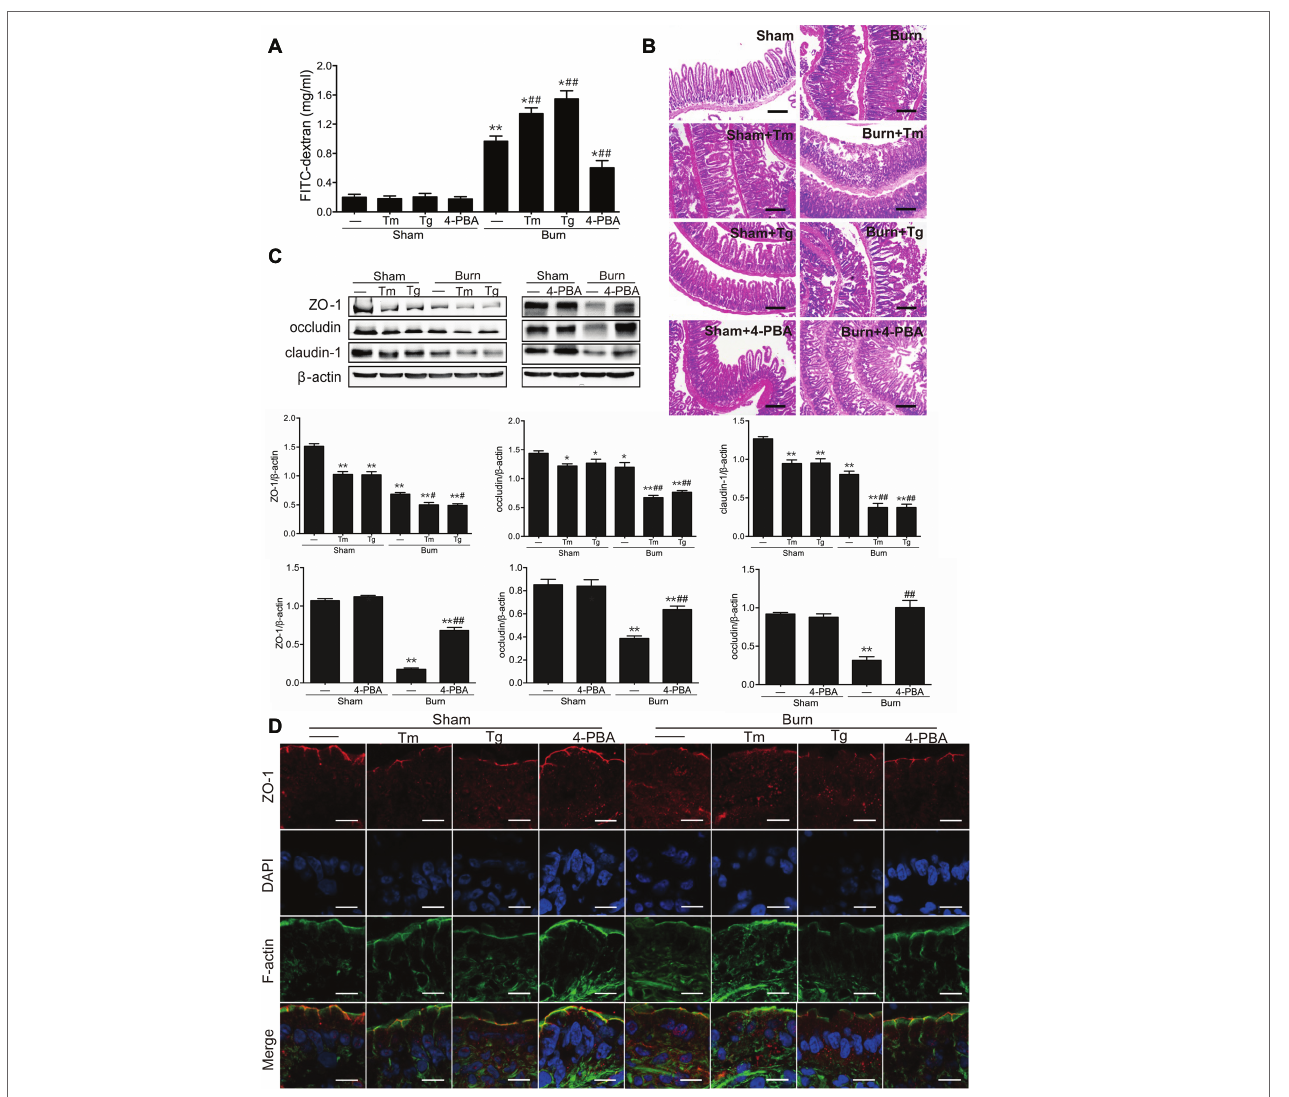
FIGURE 2 | Severe burn-induced intestinal epithelial tight junction (TJ) barrier dysfunction is aggravated by ER stress inducers and alleviated by ER stress inhibitor. Mice were treated as described in Figure 1 . (A) Intestinal permeability to 4.4 kDa FITC-dextran was measured at 6 h after sham burn or burn injury as described in “Materials and Methods.” Data represent mean ± SEM. * p < 0.05, ** p < 0.01, compared with sham-burn group ( n = 5). # p < 0.05, ## p < 0.01, compared with burn group ( n = 5). (B) Hematoxylin and eosin staining of distal ileal segments was performed at 6 h following sham burn or 30% TBSA burn. Data are representative of five independent experiments. Scale bar = 200 μm. (C) Immunoblot was performed to determine the expression of ZO-1, occludin, and claudin-1, with β -actin as loading control. Data represent mean ± SEM. * p < 0.05, ** p < 0.01, compared with sham-burn group ( n = 5). # p < 0.05, ## p < 0.01, compared with burn group ( n = 5). (D) ZO-1 was stained by immunofluorescence assay. Data are representative of five independent experiments. Scale bar = 20.0